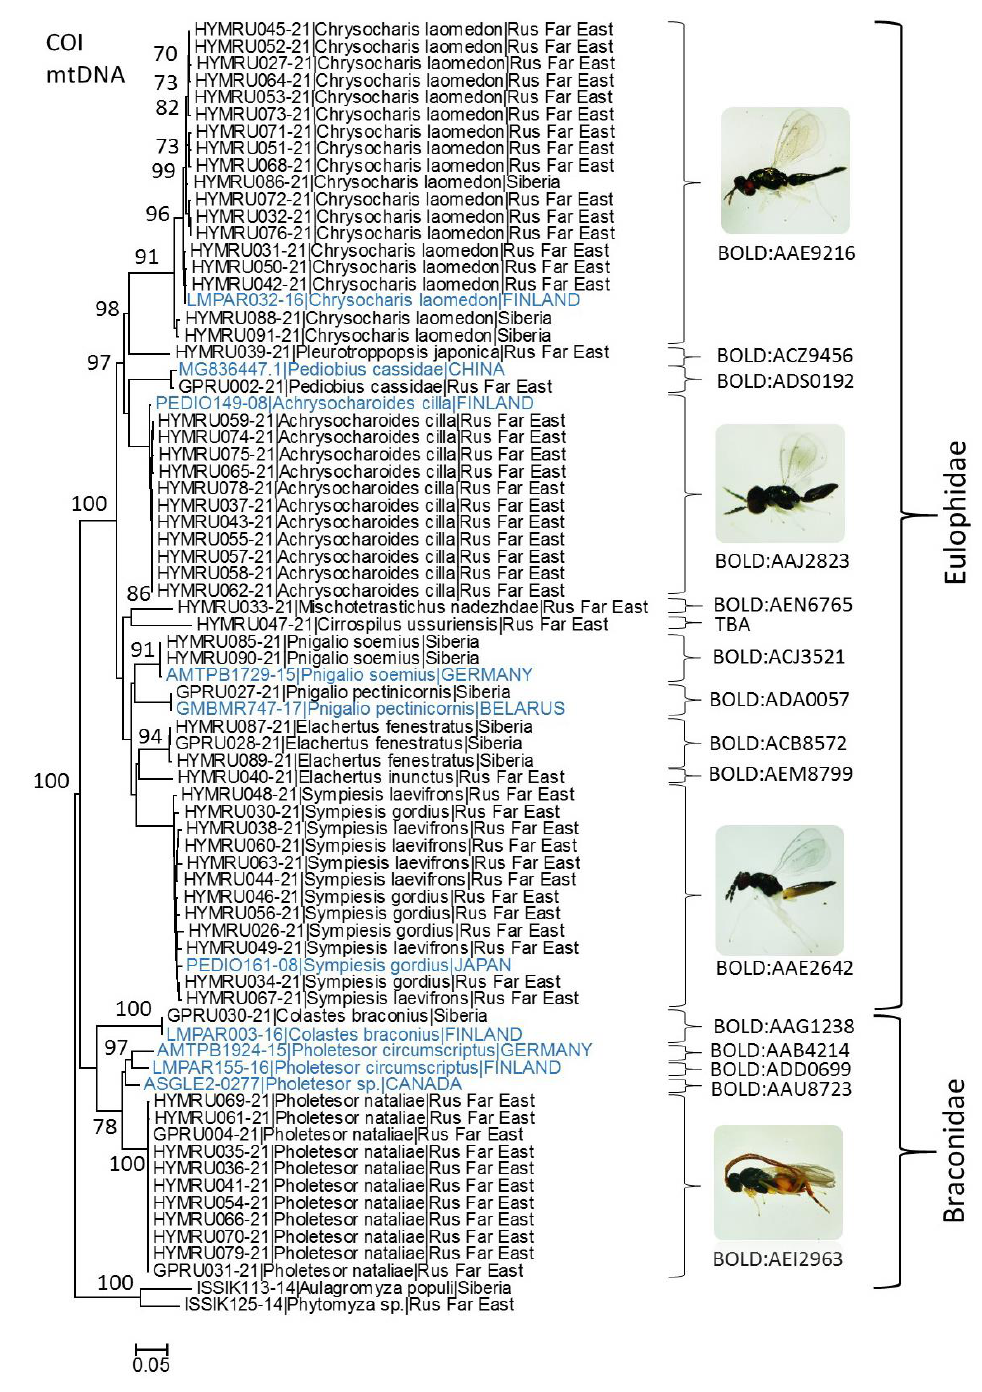
Figure 3. Maximum likelihood tree showing the relatedness of hymenopteran parasitoids grown from larvae and pupae of Phyllonorycter issikii in Asian Russia in 2020–2021, with closest neighbors in BOLD (borrowed sequences are indicated in blue). Each specimen is indicated by the BOLD process ID (begins with HYMRU or GPRU), followed by species name, country or macroregion (Siberia, Rus Far East = Russian Far East). Bootstrap values > 70 are indicated next to the corresponding branches. BIN numbers are given next to each cluster. The images of adults are provided for most frequently recorded species.